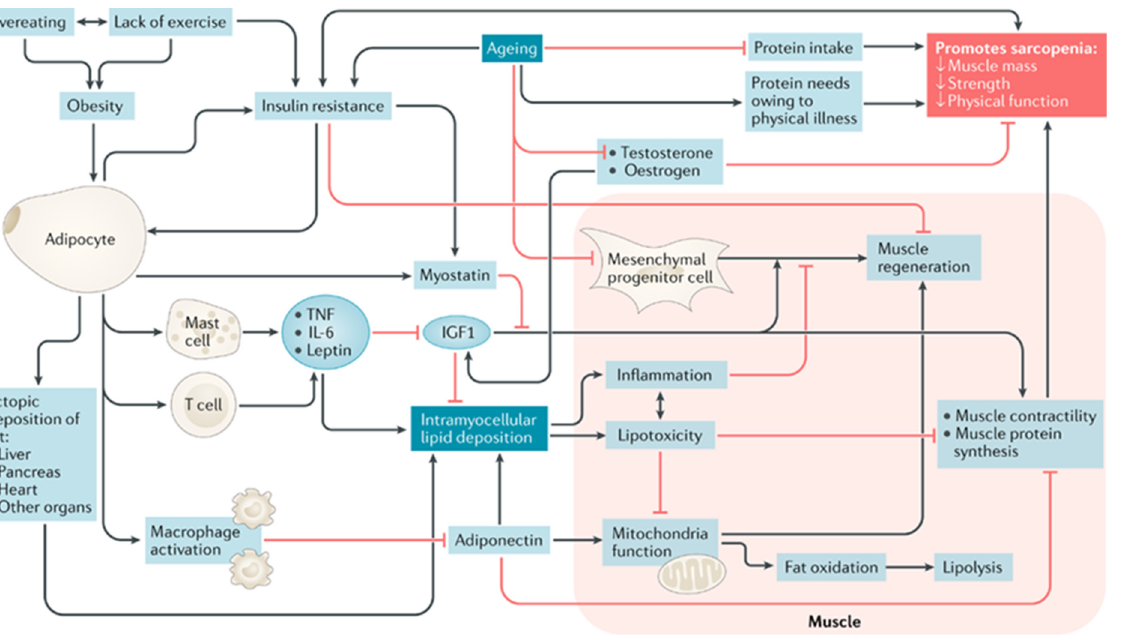
Figure 2. A proposed model of mechanisms leading to sarcopenic obesity. The proposed interplay between adipose and muscle tissue, which is believed to contribute to the development of sarcopenic obesity, is shown. The black lines are stimulatory, while red lines with flat ends indicate inhibition. IGF1, insulin ‐ like growth factor 1; TNF, tumor necrosis factor [10].